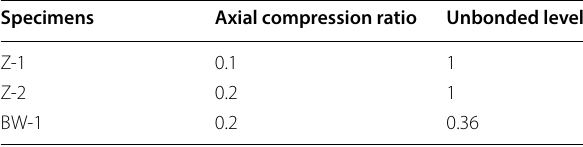
Table 1 Variable parameters of three specimens.